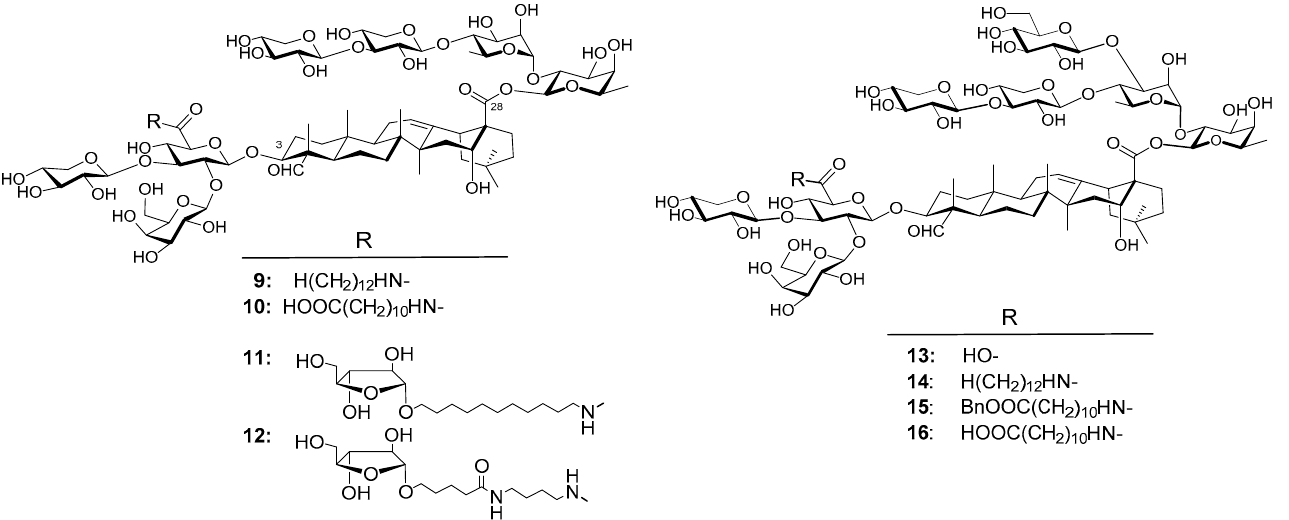
Figure 5. Synthesized QS analogs.